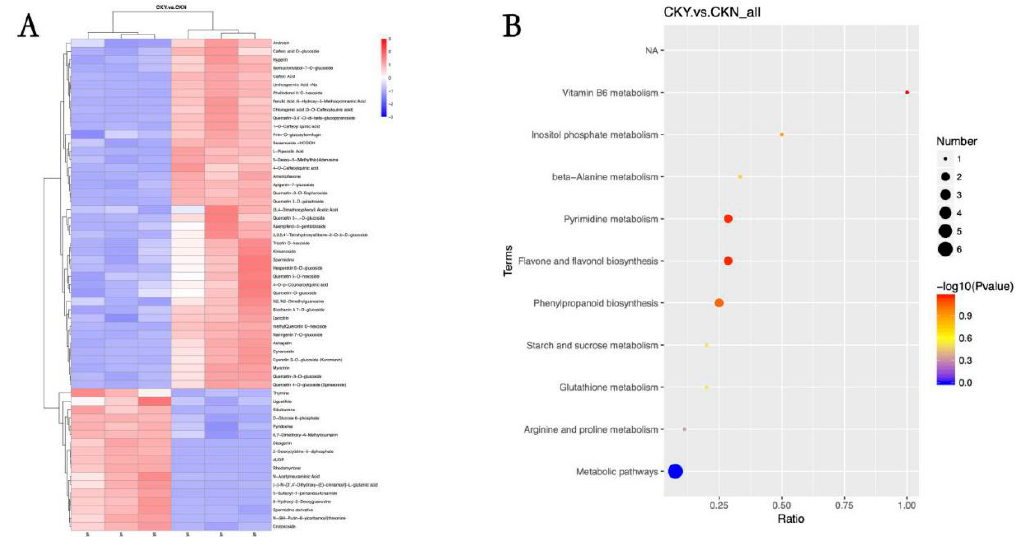
Figure 7. Heat maps of various metabolites clustering ( A ) and metabolic pathway KEGG enrichment bubble map ( B ) of the russet CKY versus non-russet CKN comparison. Sample clustering is shown in the branching diagram at the top of ( A ), while the metabolite clustering is shown in the branching diagram at the left side of ( A ). Shorter branches indicate higher similarity. Red represents up-regulation, while blue represents down-regulation ( A ). The abscissa in ( B ) is x / y (where x is the number of di ff erential metabolites in the corresponding metabolic pathway and y is the total number of metabolites identified in the pathway). The colors of the points represent the p -values of a hyper geometric test. The smaller the value, the greater the reliability and statistical significance. The size of the point represents the number of di ff erential metabolites in the corresponding pathway. The larger the point, the more differential metabolites occur in the pathway ( B ).